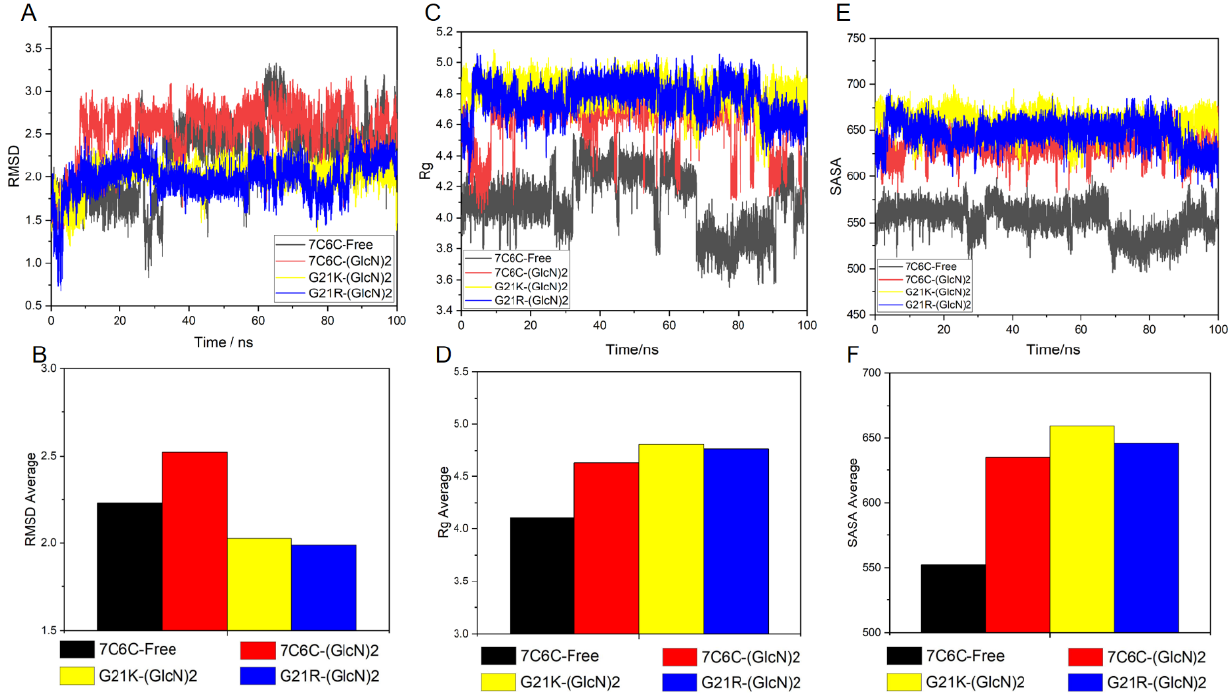
Figure 8. Analysis of active residues in Ile145-Gly148 fragment of each reaction system. ( A ) RMSD; ( B ) RMSD average; ( C ) Rg; ( D ) Rg average; ( E ) SASA; ( F ) SASA average. Protein active pocket analysis is important to study protease activity. The active pocket region in the MD simulation was calculated using POCASA [15]. Changes in active pocket volume were examined after 0, 50 and 100 ns (Figure 9A–D). Compared with the free protein, the active pocket volumes of the three complex systems increased. In the two mutants, they were bigger than in the 7C6C-(GlcN) 2 complex, which may be useful for the substrate to slide into and to start the catalytic reaction. This may be one of the reasons for the improvement of enzyme activity in the two